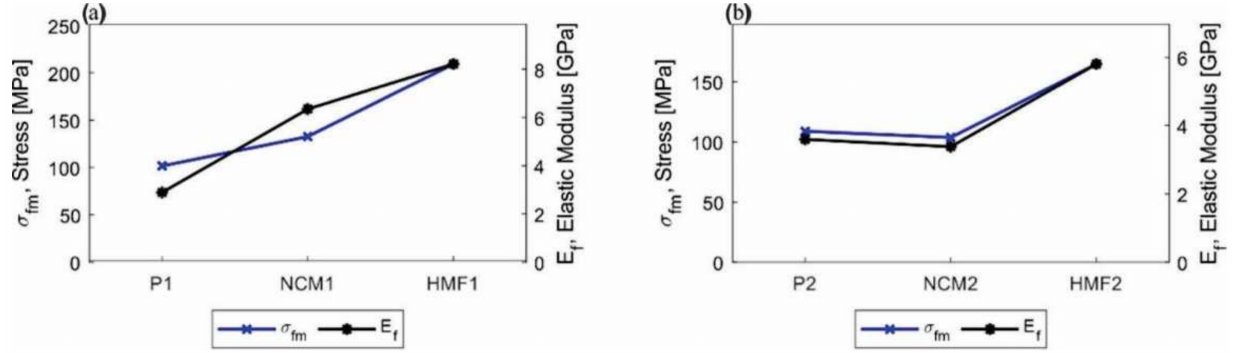
Figure 7. Graphic comparative summary of the maximum effort and elastic modulus in bending. ( a ) Test pieces made with configuration 1 (P1, NCM1, and HFM1) and ( b ) test pieces made with